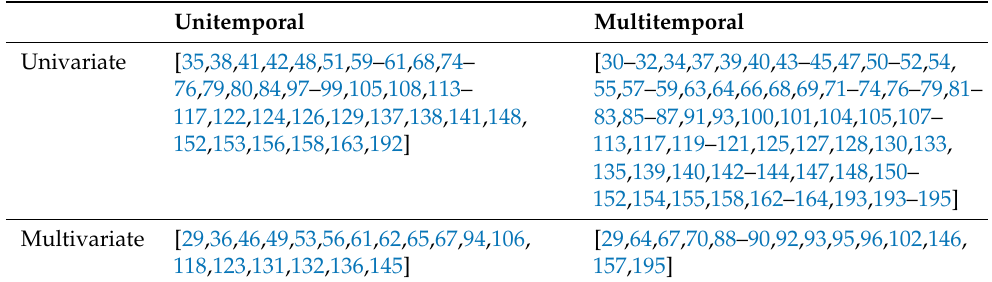
Table 1. Reconstruction approaches sorted according to the novel variate-temporal categorisation system.